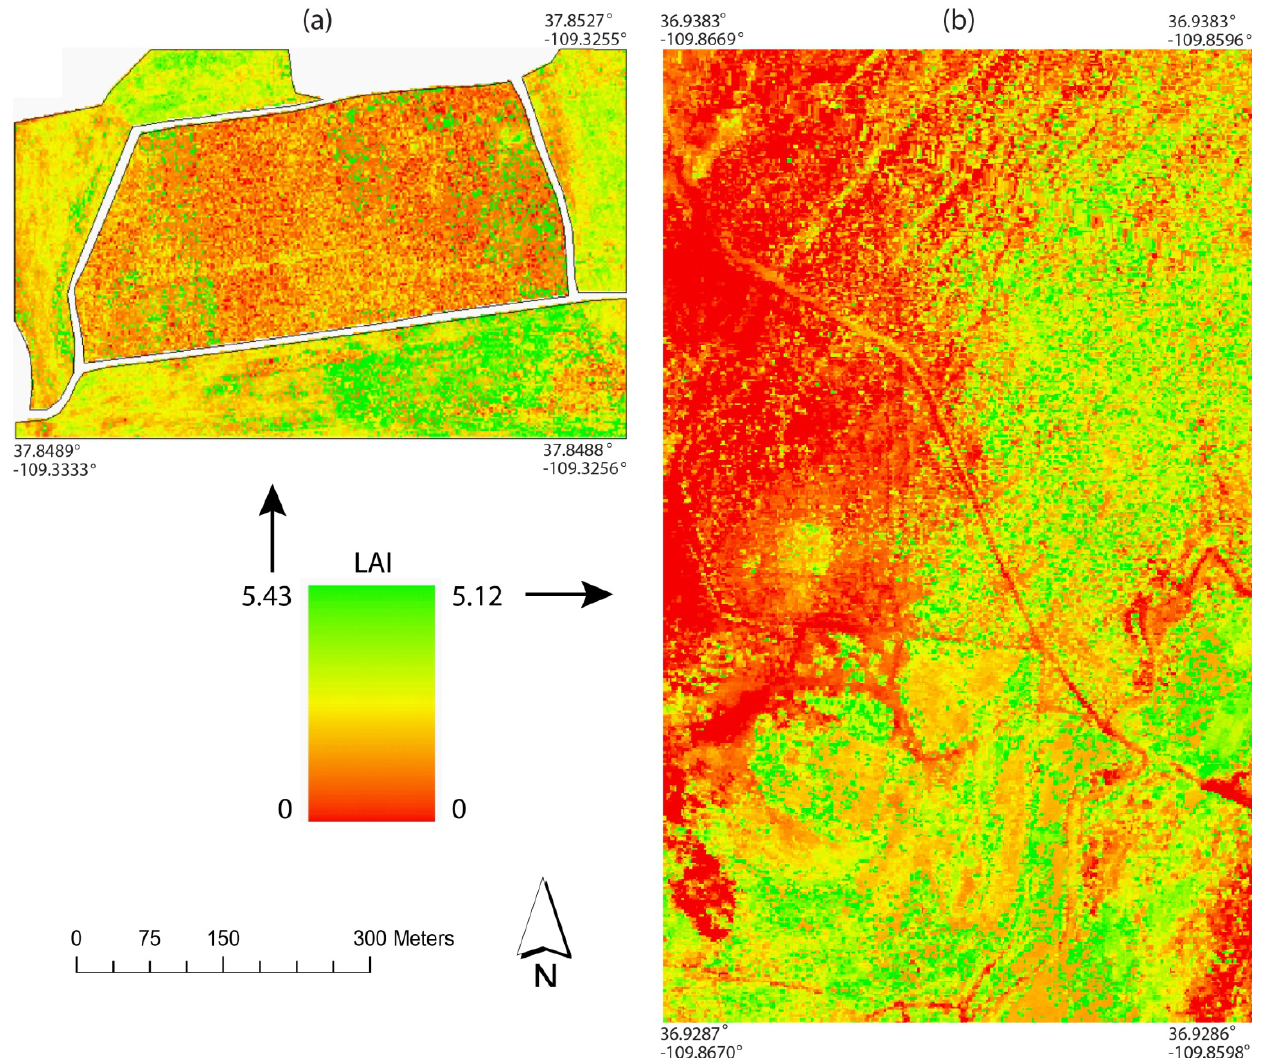
Figure 6. The estimated LAI distribution maps for ( a ) the Monticello site, and ( b ) the Monument Valley site. The dirt road and other land cover classes were masked out for the Monticello